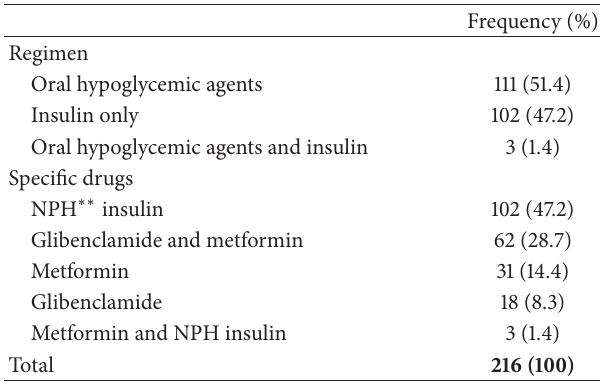
Table 2: The regimen and specific drugs used to manage types I and II diabetes in Dessie Referral Hospital, 2013 ( 𝑛 = 216